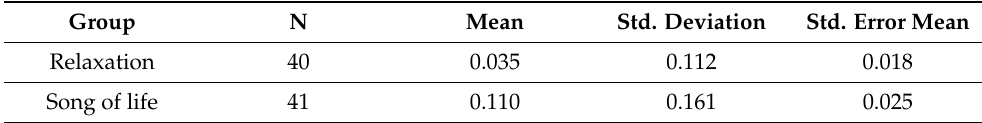
Table 6. Variance analysis result for both groups.